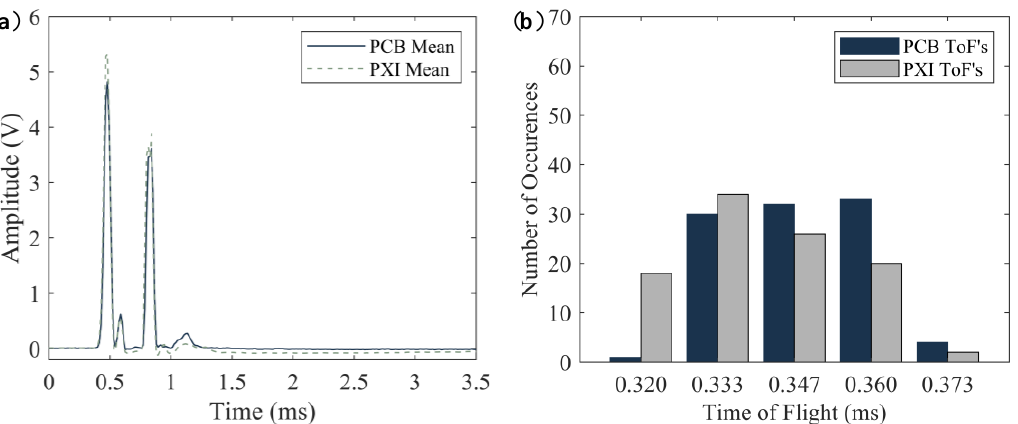
Figure 13. Granite test. ( a ) time-series obtained by averaging the 100-time waveforms measured with the sensor disks. ( b ) Number of occurrences of a given ToF. For each color, the total number of occurrences is 100.